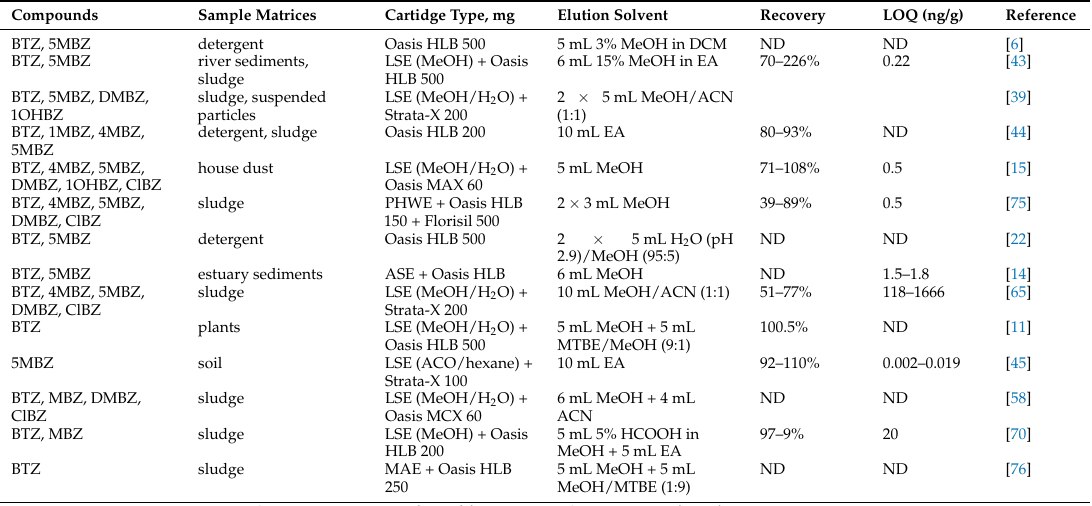
Table 3. SPE methods reported for benzotriazoles in solid samples (ND–no data). Compounds Sample Matrices